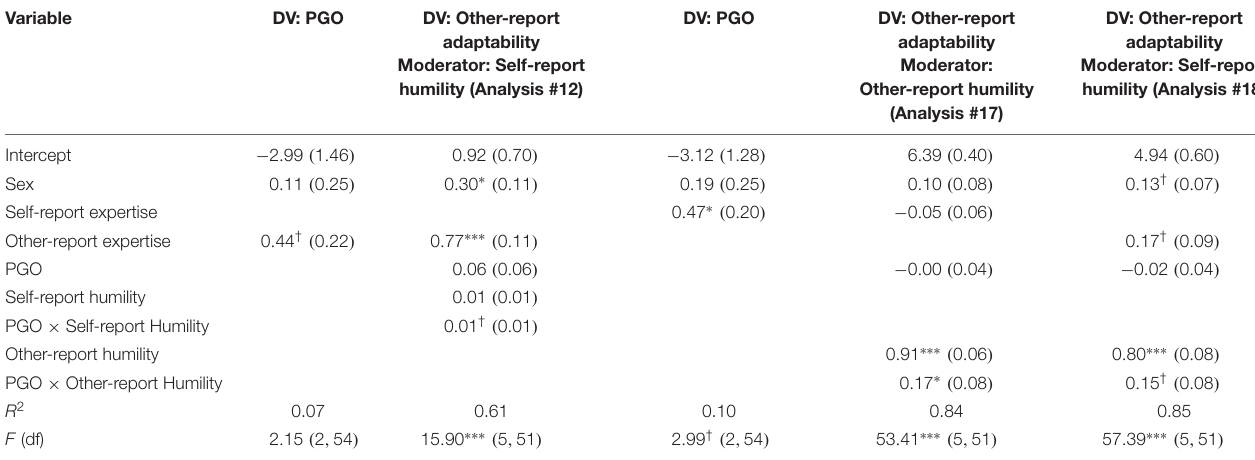
TABLE 5 | Results of conditional process analyses #12, 17, and 18.